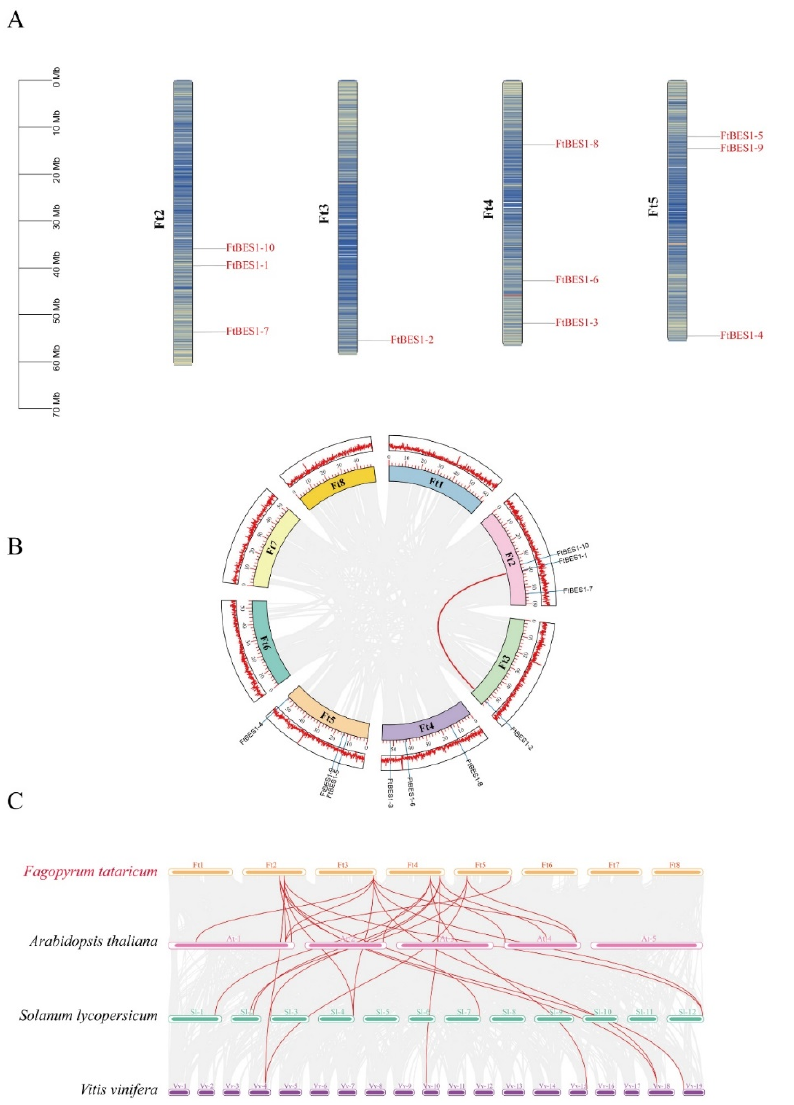
Figure 4. FtBES1 chromosome localization, genome duplication and covariance of BES1 between buckwheat FtBES1 and different species. ( A ) Distribution of FtBES1 gene in Tartary buckwheat chromosomes. ( B ) Analysis of covariance within the Tartary buckwheat FtBES1 , the same color indicates the Tartary buckwheat chromosomes in the duplication of segments. The gray background indicates the Tartary buckwheat genome common line region and Tartary buckwheat each chromosome with a different color distinction; the outer circle indicates the chromosomal gene density. ( C ) Analysis of covariance between Tartary buckwheat FtBES1 and Arabidopsis , tomato and grape. Red lines indicate covariance BES1 gene pairs; gray lines indicate covariance gene pairs in the genomes of Tartary buckwheat, Arabidopsis , tomato and